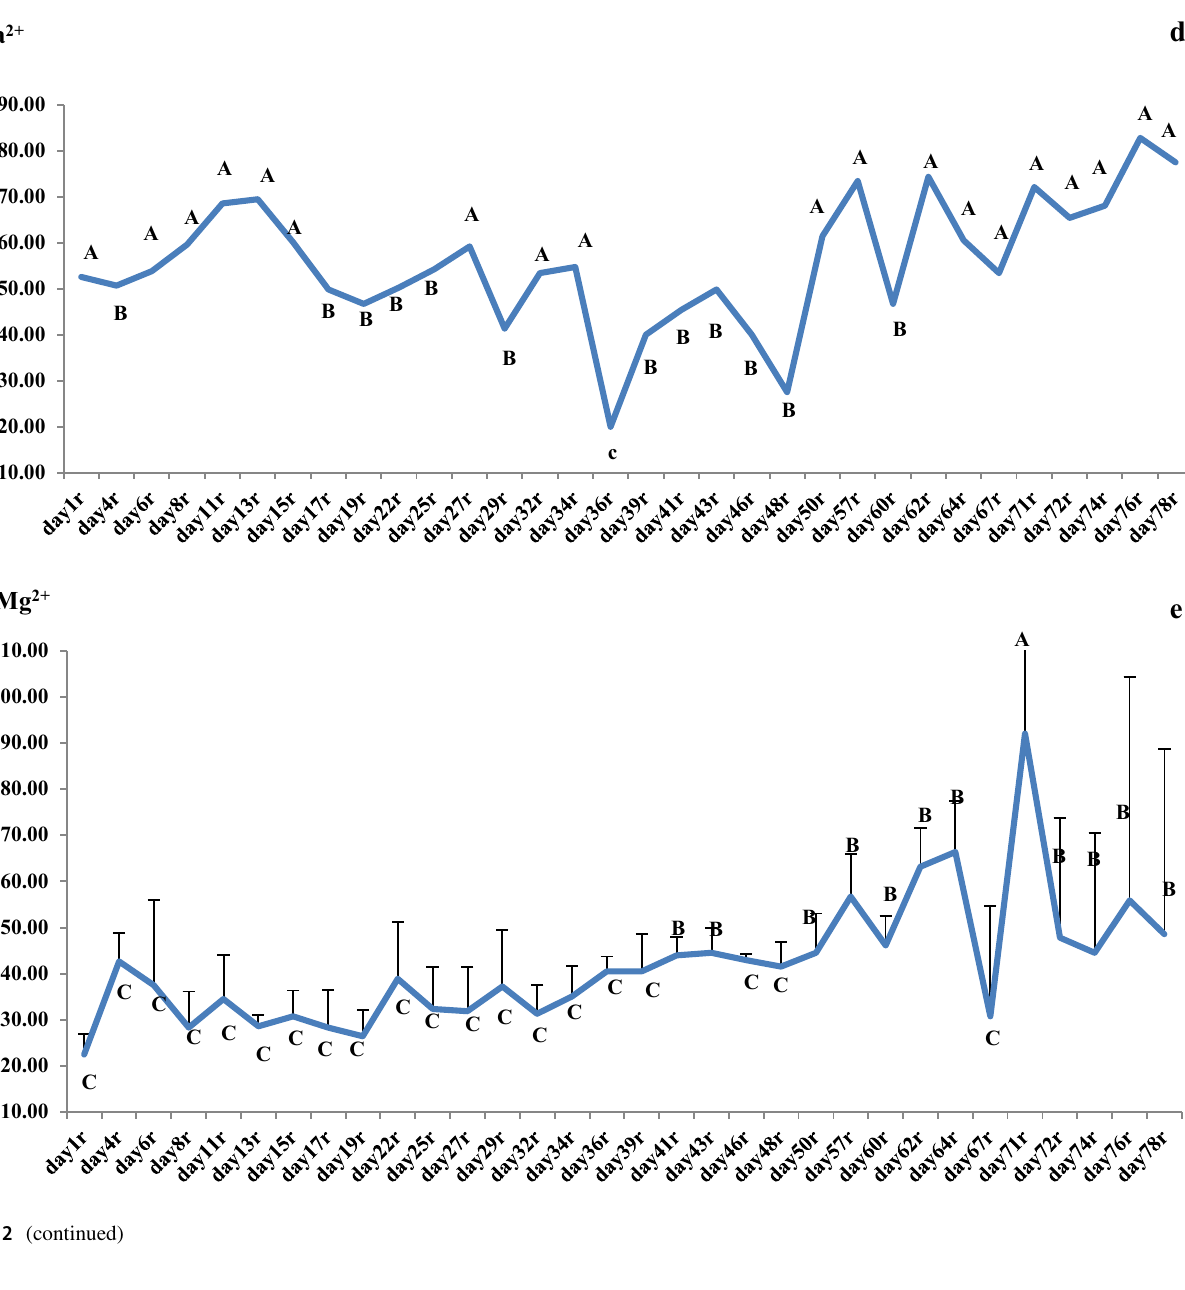
Table 3 Effect of water nature on measured parameters (means and homogeneous groups) Water